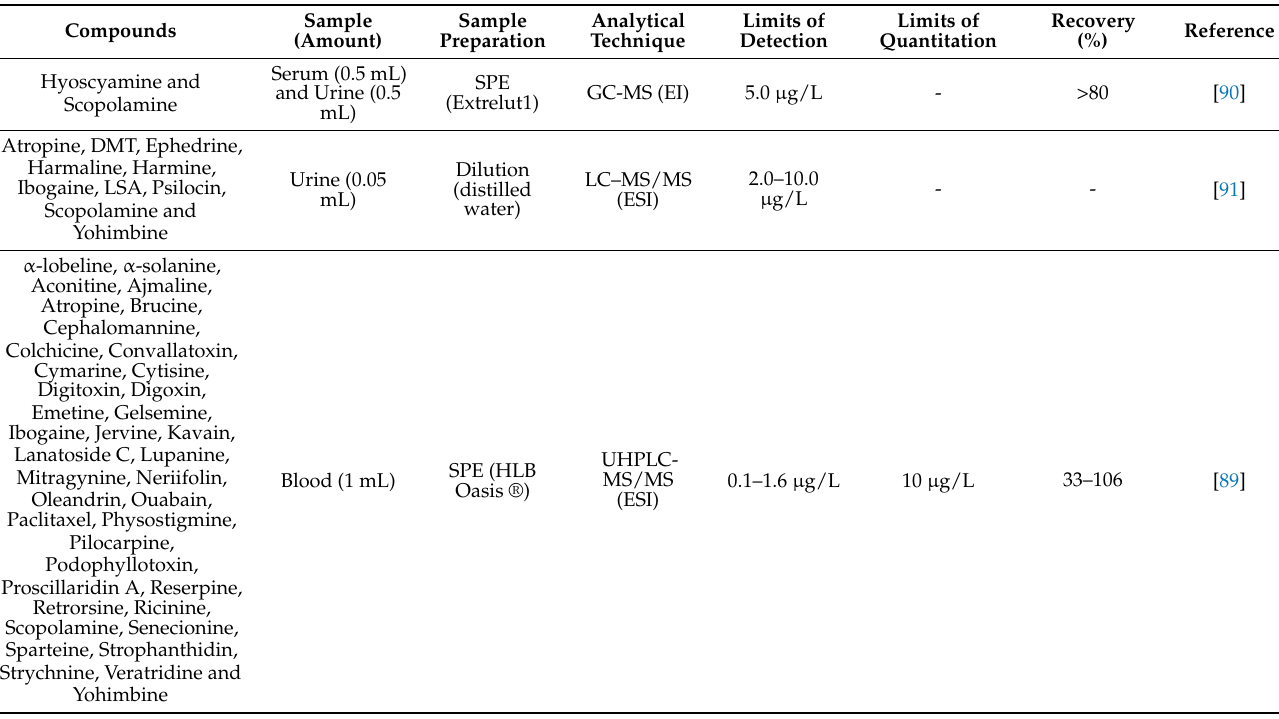
Recovery (%) Reference